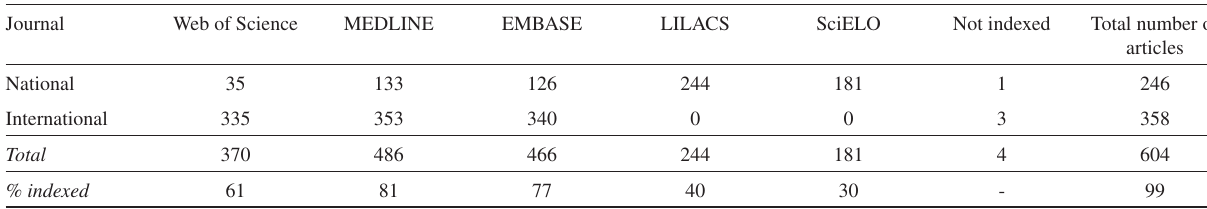
Table 1 - Articles published by authors from InCor, according to the databases in which they were indexed, from 2000